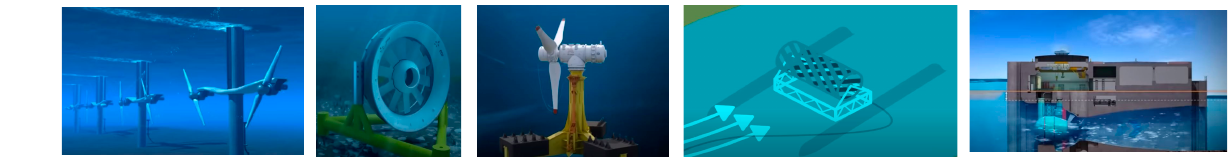
Figure 29. Tidal stream installation [66].